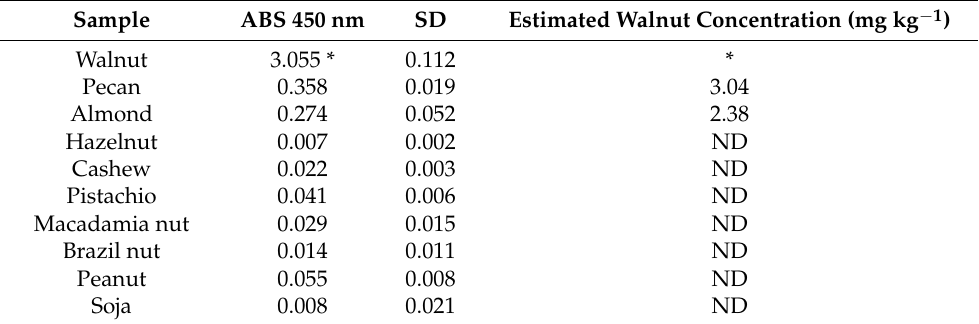
Table 2. Determination of cross-reactivity with heterologous species using the sandwich ELISA kit for walnut.